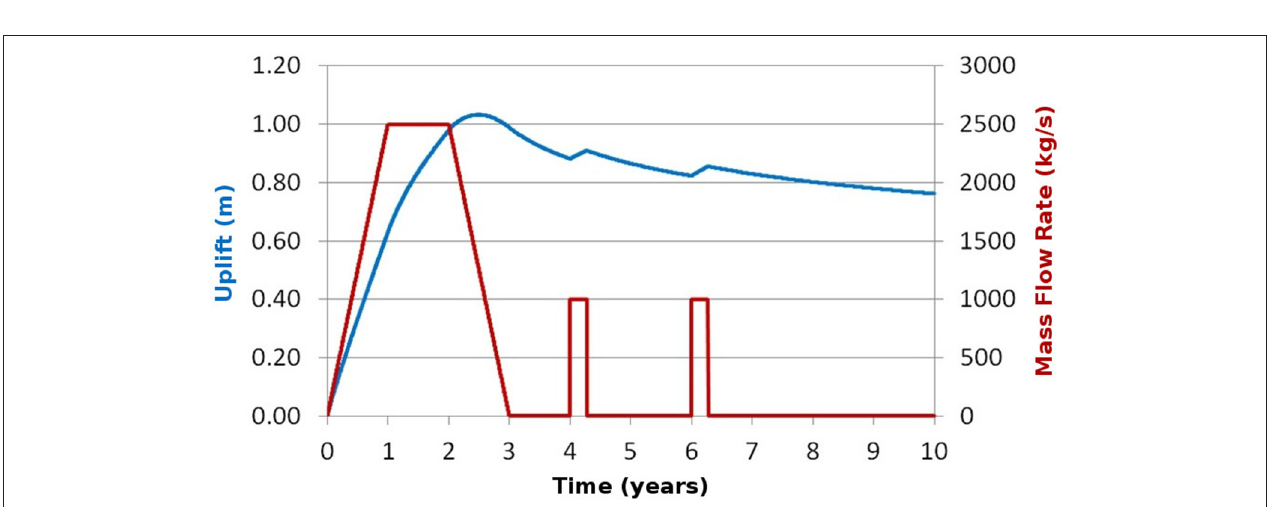
FIGURE 6 | Simulation of the uplift in the maximum uplift point (blue line, left axis) for multiple magma inputs repeated in time. A main input is followed by two smaller magmatic inputs (red line, right